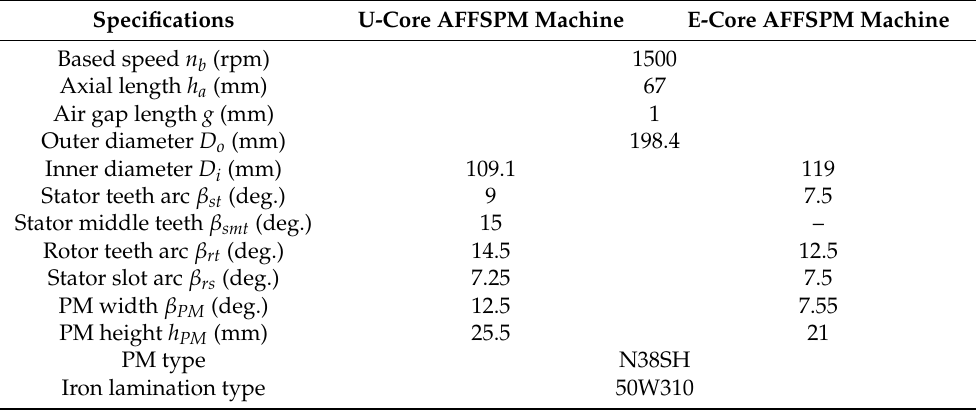
Figure 3. Schematic diagram of double three phase open winding and H-bridge inverter drive topology. ( a ) Double three open winding configuration; ( b ) H-bridge inverter drive topology. Table 1. Key specifications and dimensions of two axial field flux-switching machines.